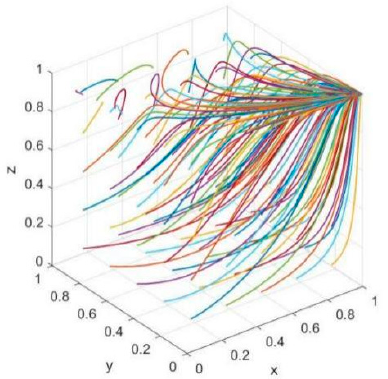
Figure 3. Evolutionary simulation at the initial stage point (1, 1, 0).